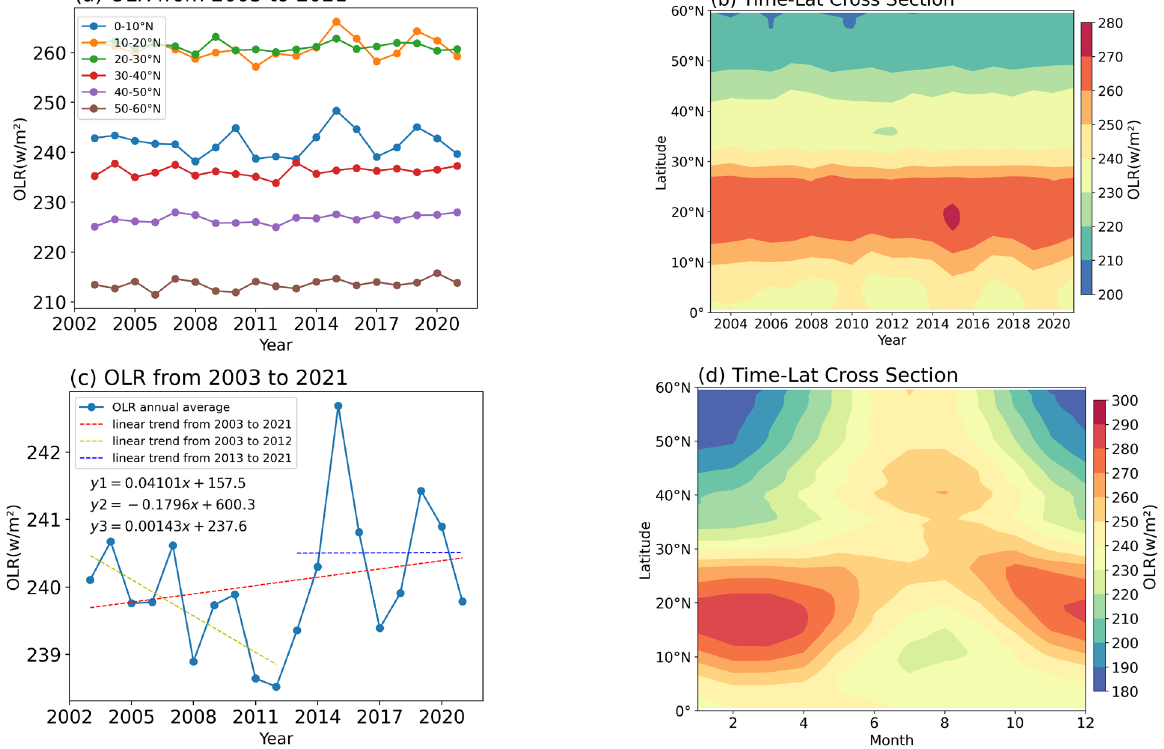
Figure 4. OLR multi-dimensional and multi-angle analysis. ( a ) Time-series changes of the same longitude and different latitudes. ( b ) Year time and latitude changes. ( c ) Time-series changes in special areas. ( d ) Monthly time and latitude changes.